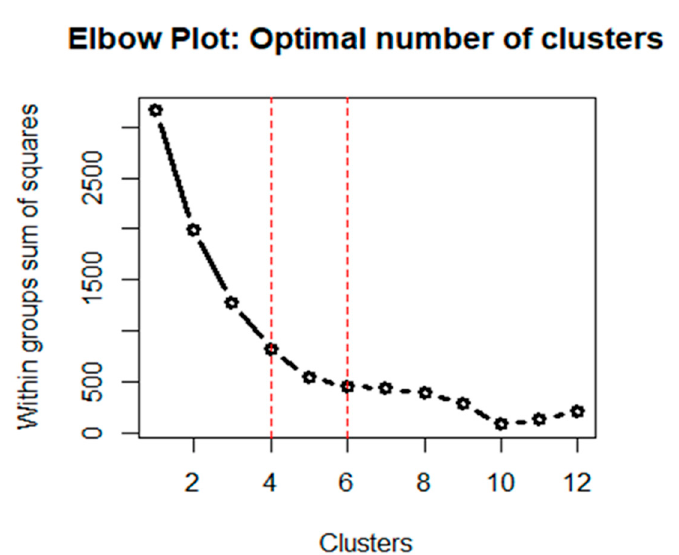
Figure 3. Elbow plot. An automatic procedure recognizes the 6 theoretical clusters groups (within groups sum of squares, WSS6 = 509.13). The k-means method suggests that a good representation of clusters is given from 4 to 10 groups. By using a parsimonious point of view, 4 clusters (phenotypes) were selected (WSS4 = 838.93). According to cluster estimation, the agreement between induced classification and automatic classification was 31.6%.